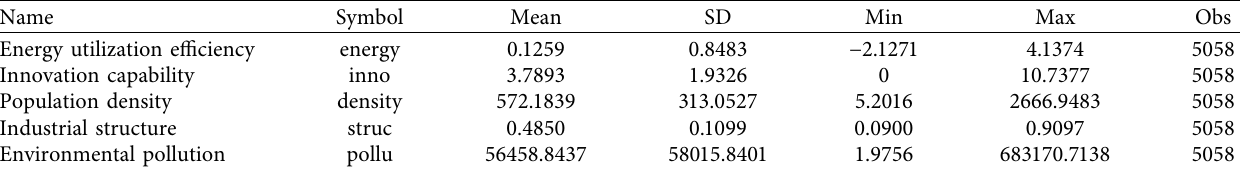
Table 1: Descriptive statistics of variables.